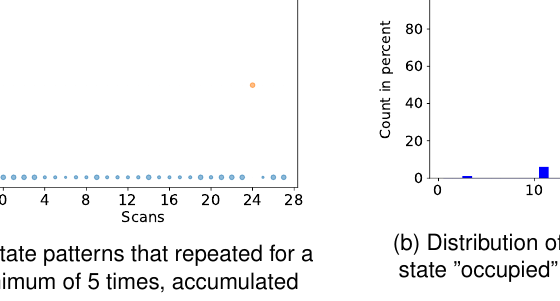
Figure 15. Pattern distribution for a